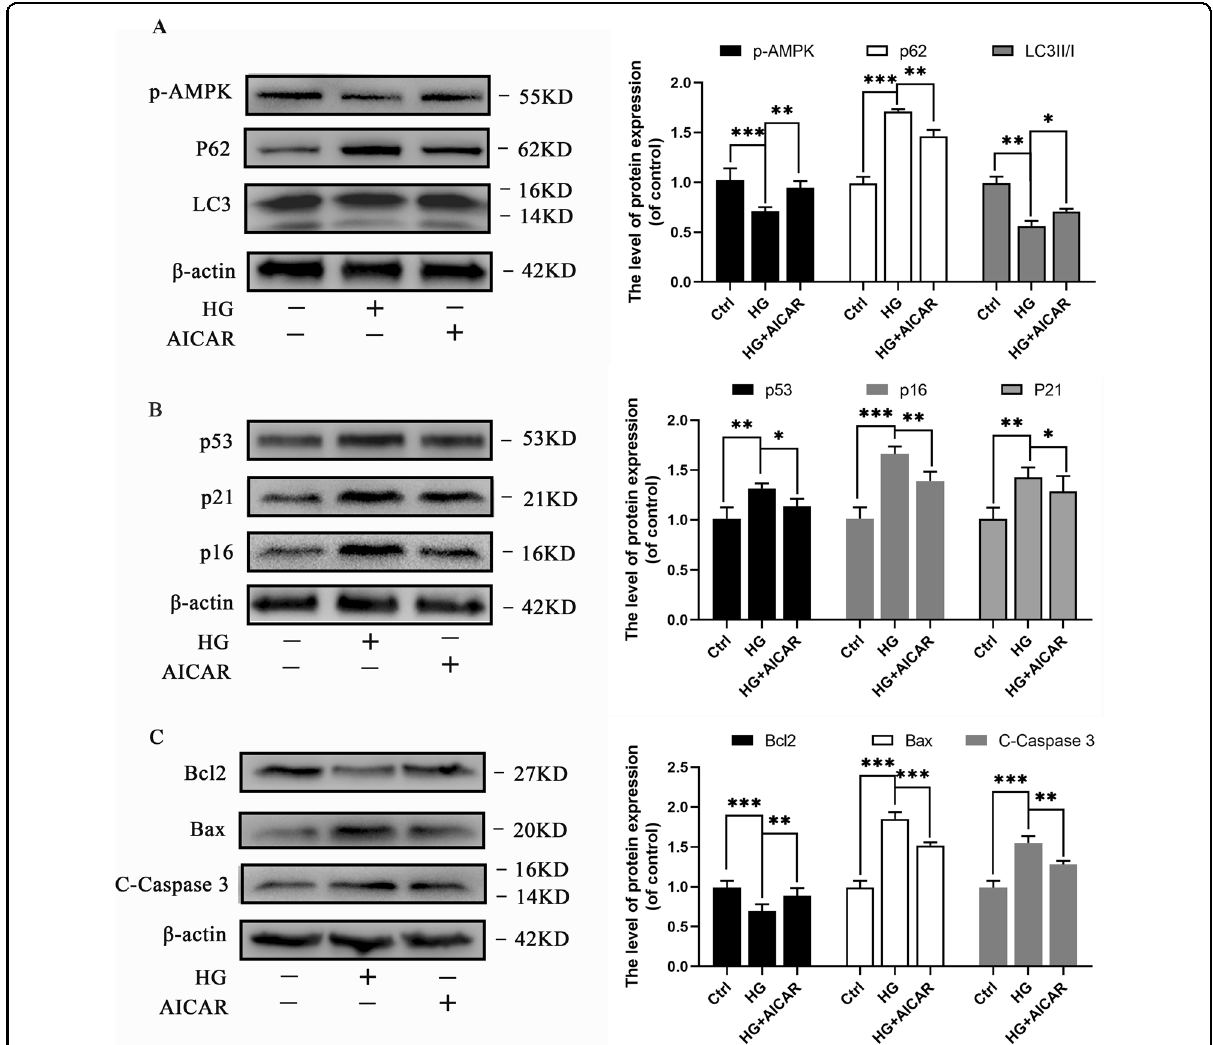
Fig. 4 Activation of AMPK promotes autophagy and suppresses apoptosis and senescence in chondrocytes. A Western blot results and quanti fi cation analyses of p-AMPK, p62, and LC3 in various treatment groups. B Western blot results and quanti fi cation analyses of p53, p21, and p16 in various treatment groups. C Western blot results and quanti fi cation analyses of Bcl2, Bax, and cleaved caspase-3 in various treatment groups. Data are presented as means ± SD ( n = 5). * P < 0.05, ** P < 0.01 , and *** P <